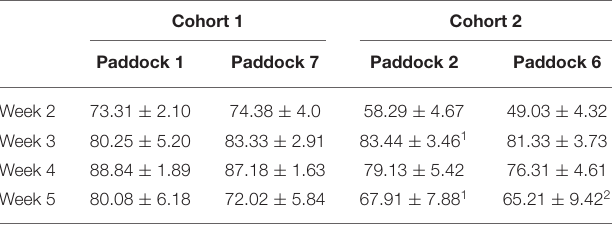
TABLE 1 | The mean ± SEM percentage of audio-only cues that were received for each group of animals (indicated by paddock) within two cohorts across 4 weeks following virtual fence